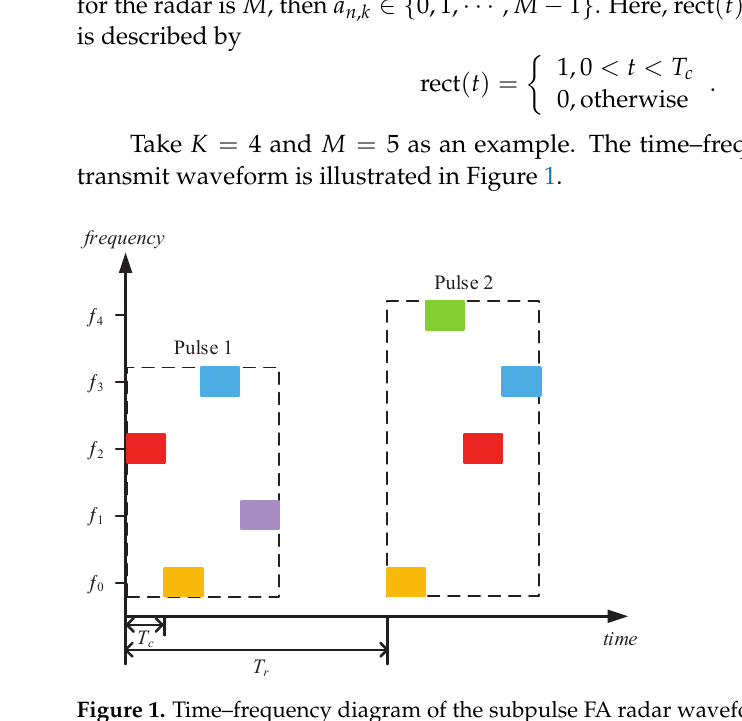
Figure 1. Time–frequency diagram of the subpulse FA radar